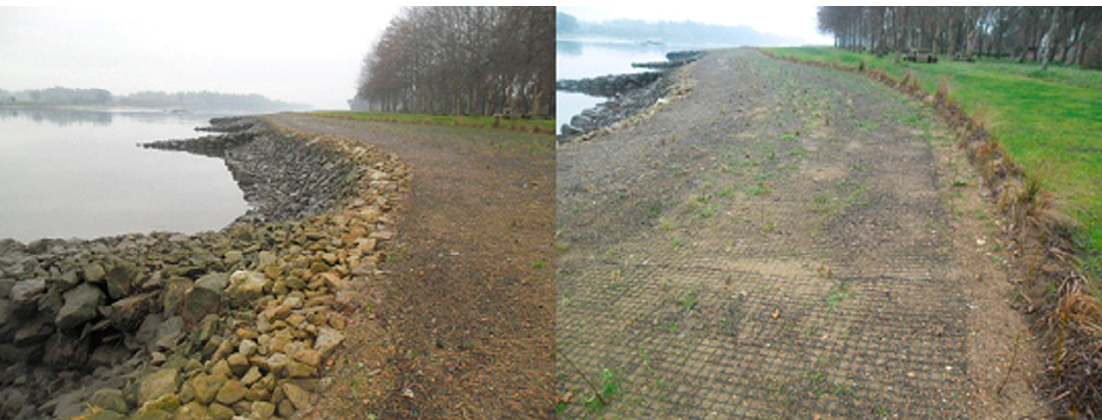
Figure 6. Rip-rap (left) and first row of small groynes (right) in Cardielos, after the implementation of the project in Cardielos in 2014.